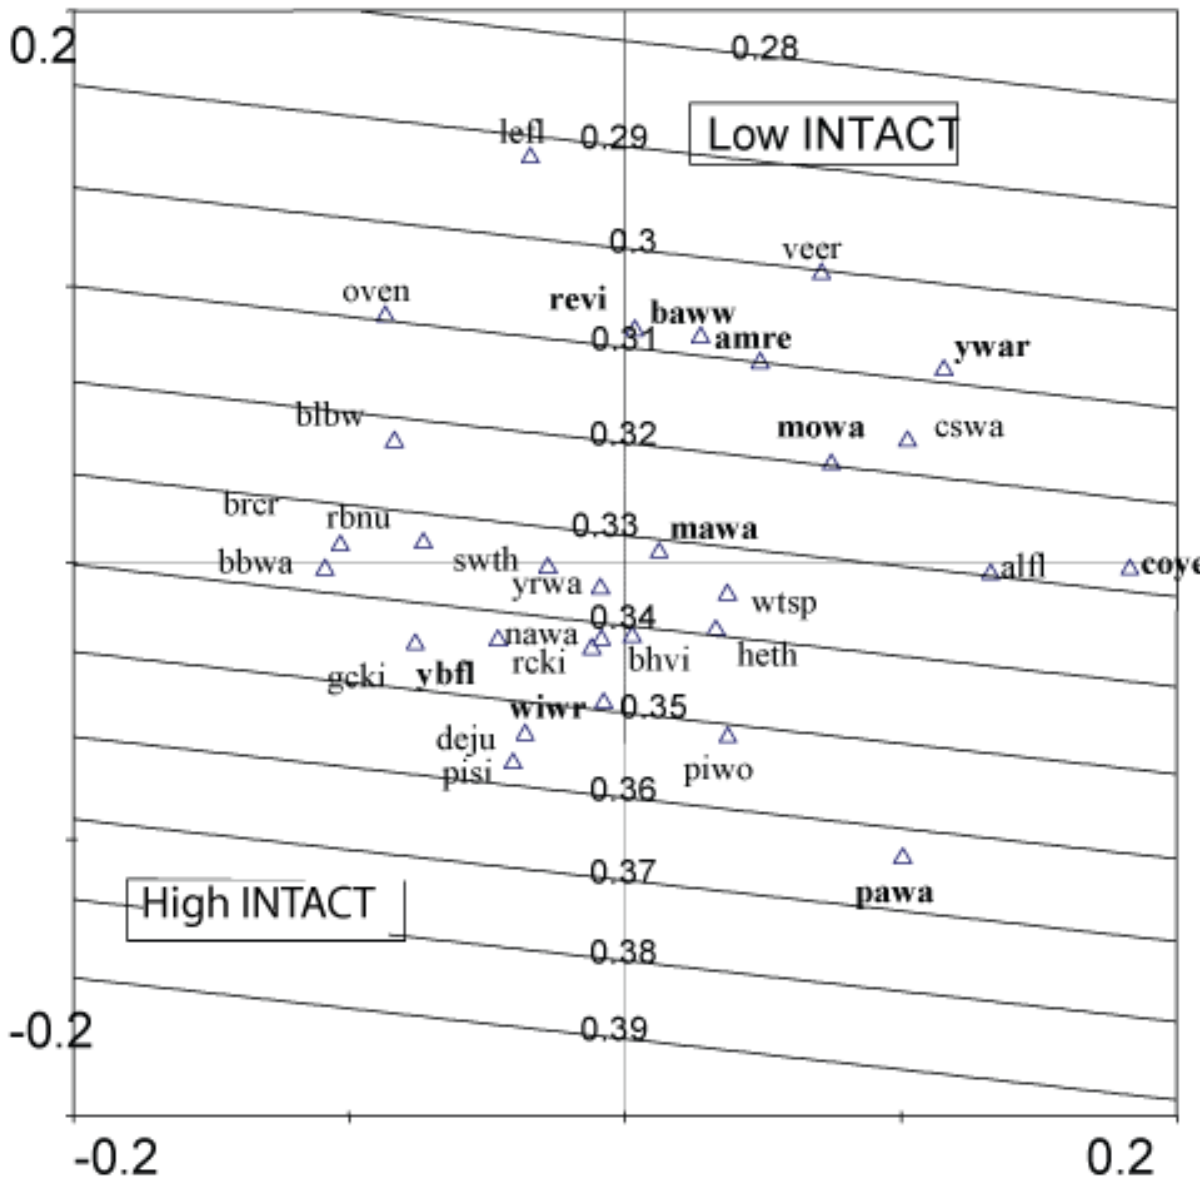
Fig. 4. Species ordination (CCA), with overlay of isopleths (GLM) for proportion mature and old forest (INTACT). Species with a significant effect (ANOVA p < 0.05) are highlighted in bold. Isopleths delineate species predicted to occur in areas of low to high proportions of intact mature